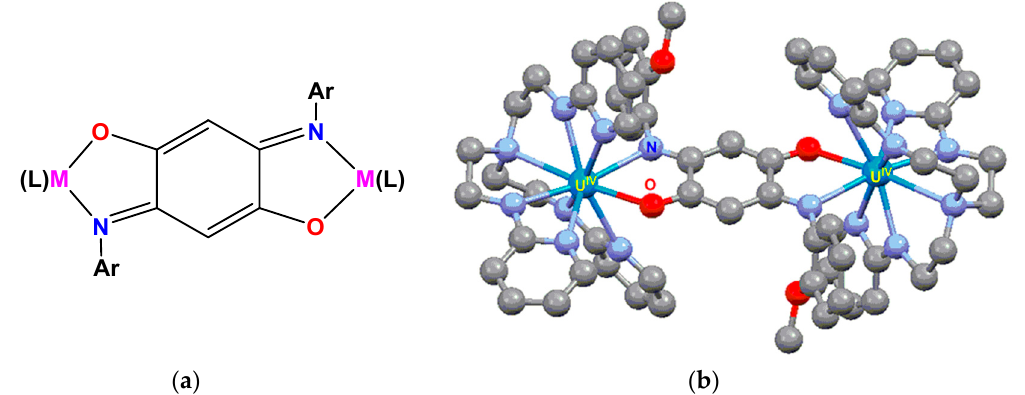
Figure 23. Schematic depiction ( a ) and molecular structure ( b ) of the imino-alkoxy quinoid diuranium(IV) [U(L)] 2 Q OMe system. (reprinted with permission from [156], the Royal Society of Chemistry, 2017).